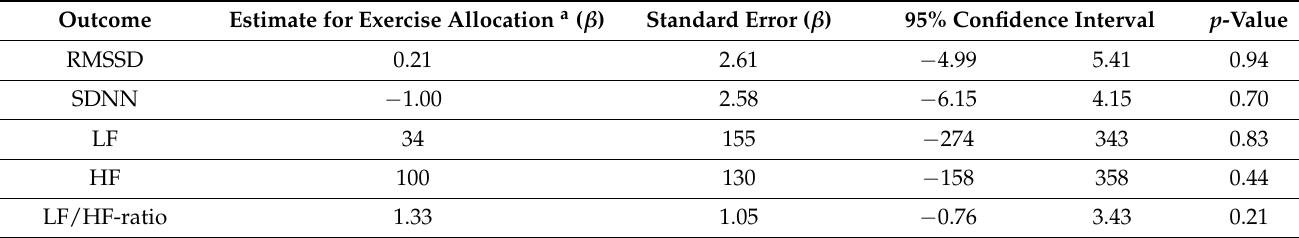
Table 5. Coefficients of exercise allocation in intent-to-treat ANCOVA models predicting HRV outcomes during the pre-sleep